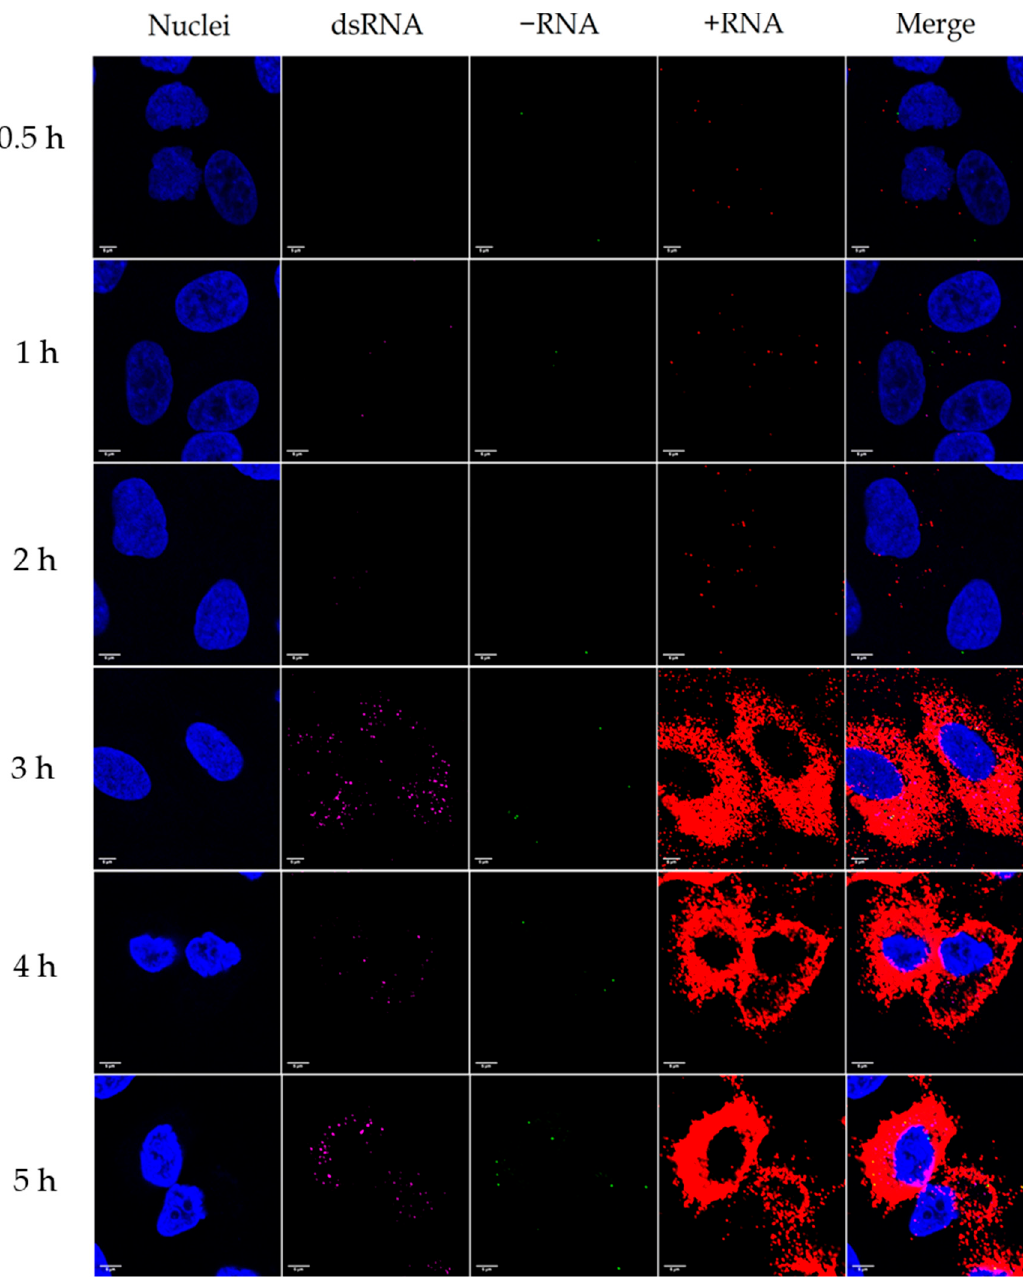
Figure 3. Distribution of viral − RNA, + RNA, and double-stranded RNA (dsRNA) in CVA9-infected cells 0.5–5 h p.i. Nuclei are shown in blue, dsRNA is shown in magenta, − RNA is shown in green, and + RNA is shown in red. The rows from top to bottom are 0.5, 1, 2, 3, 4, and 5 h p.i. Some dsRNA could be seen at 0.5–2 h p.i., but the amount of dsRNA surged at 3 h p.i. The amount of − RNA at